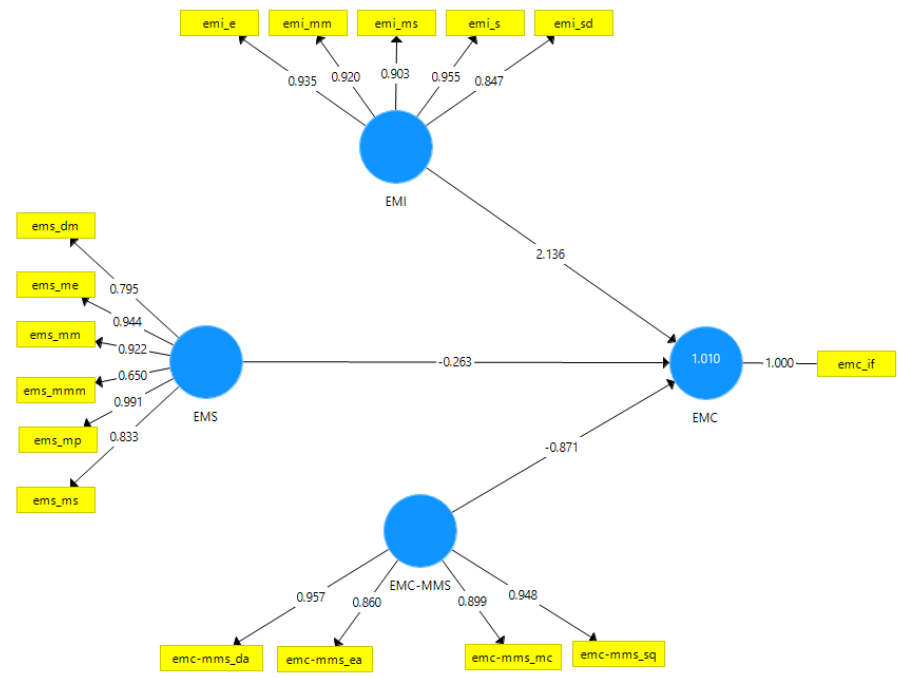
Figure 2. Indicator loadings. Source: Results from Smart-PLS software 3.3.3.